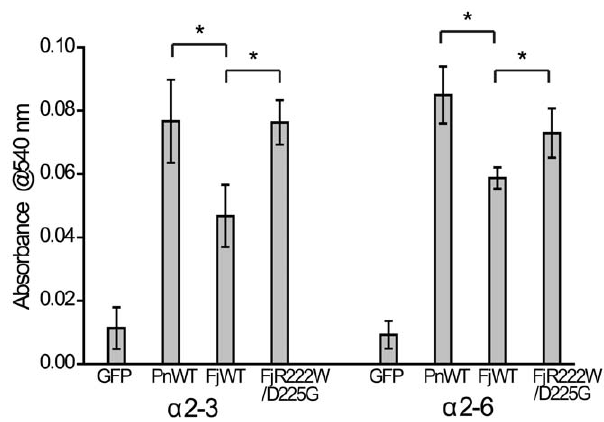
Figure 3. Experimental validation of amino acid residues critical for altered receptor-binding specificity of Fujian-like viruses. Comparison of receptor binding activities of wild type Panama and Fujian HAs and Fujian HA with R222W and D225G mutations (FjR222W/D225G). Briefly, the wild type and mutant HAs were expressed on the surface of 293T cells. Sialic acid was removed from chicken red blood cells with neuraminidase and resialylated to express either a 2–3 or a 2–6 linked sialic acid. The amount of red blood cells bound to HA expressed on the 293T cell surface was measured by absorbance at 540 nm. GFP-transfected 293T cells were used as a control for nonspecific binding. Representative data from one of the five experiments are shown. *p , 0.05.